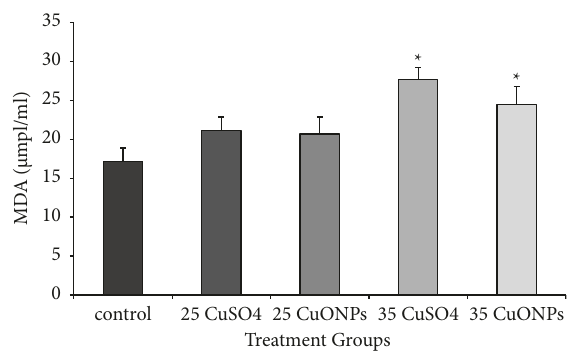
Figure 6: Lipid peroxidation (malondialdehyde) in rat testes homogenate was affected by CuO NPs and CuSO 4 0.5 (H 2 O). Data represent the mean ± standard error (SE). ∗ Significantly different ( P ≤ 0 . 05) from the control group.